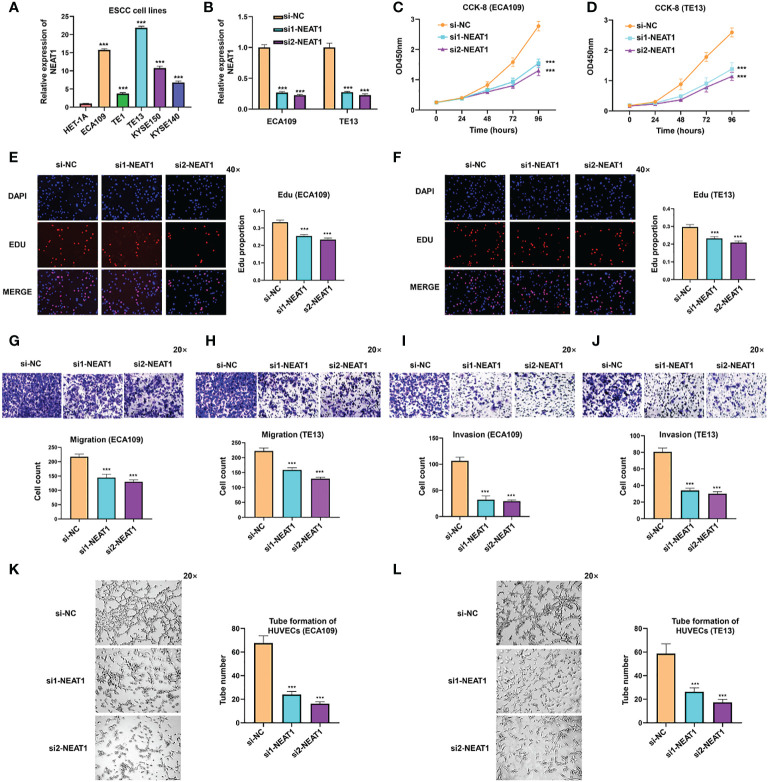
Knockdown of NEAT1 suppressed proliferation, migration and invasion of ESCC cells. (A) The expression of NEAT1 in common ESCC cell lines was verified by qRT-PCR and results showed that NEAT1 exhibited generally high levels in ESCC cell lines compared with human esophageal epithelial cell (HET-1A). (B) Two siRNAs were constructed and transfected into ECA109 and TE13 cells, and both siRNAs effectively knocked down the expression of NEAT1. (C–F) CCK-8 and Edu assays were performed to detect the proliferation rate of ESCC cells after knockdown of NEAT1 and it revealed that silencing NEAT1 significantly inhibited proliferation of ECA109 and TE13 cells. (G–J) Transwell and Matrigel assays suggested that knockdown of NEAT1 inhibited ECA109 and TE13 cells to migrate and invade. (K, L) HUVECs were seeded onto a plate precoated with Matrigel and incubated with conditioned medium from ECA109 or TE13 cells treated with silencing NEAT1 or control. Results showed that medium from cells of silencing NEAT1 significantly inhibited the tube formation of HUVECs relative to control. *P < 0.05, **P < 0.01, ***P < 0.001, n.s., no significance.